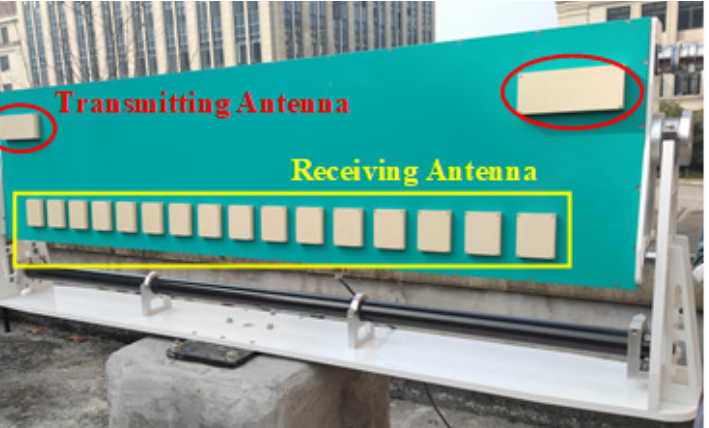
Figure 6. Photo of the ground-based multiple-input multiple-output (GB-MIMO) radar. Table 2. System parameters of the GB-MIMO radar. Parameter Value Carrier Frequency 16.2 GHz Wavelength 18.5 mm Synthetic Aperture 1.18 m Bandwidth 1 GHz Range Resolution 0.15 m Azimuth Angle Resolution